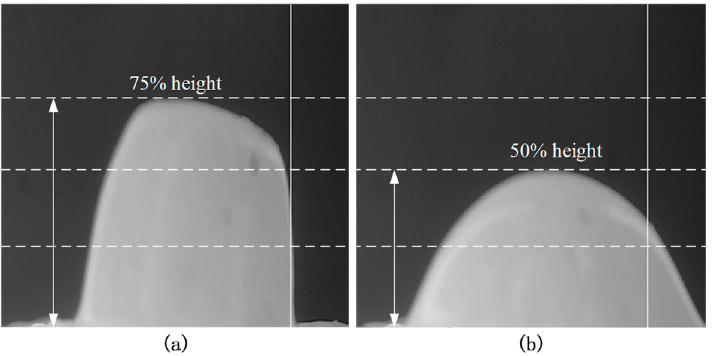
Figure 3. Photos of a sample at different melting stages: ( a ) 75% height; ( b ) 50% height.